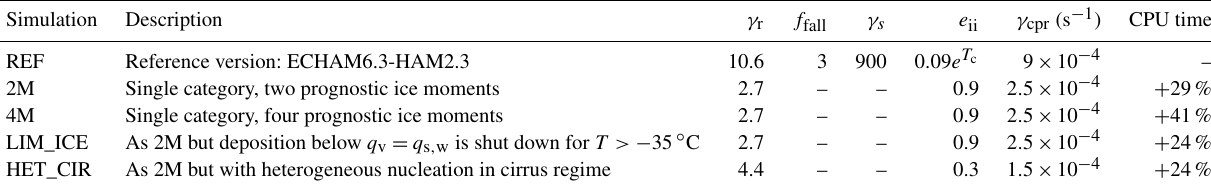
Table 2. Description of the model configurations shown in this paper. Tuning parameters are as follows: γ r is the scaling factor for warm rain formation, f fall is a scaling factor for ice sedimentation speed, γ s is a scaling parameter for snow formation, e ii is the collision efficiency of ice crystals, and γ cpr is the conversion rate from cloud water and ice to precipitation in the convection scheme. Dashes (–) denote that those parameters are no longer needed in the new scheme. The last column shows the CPU time for 1 year of simulation relative to the reference